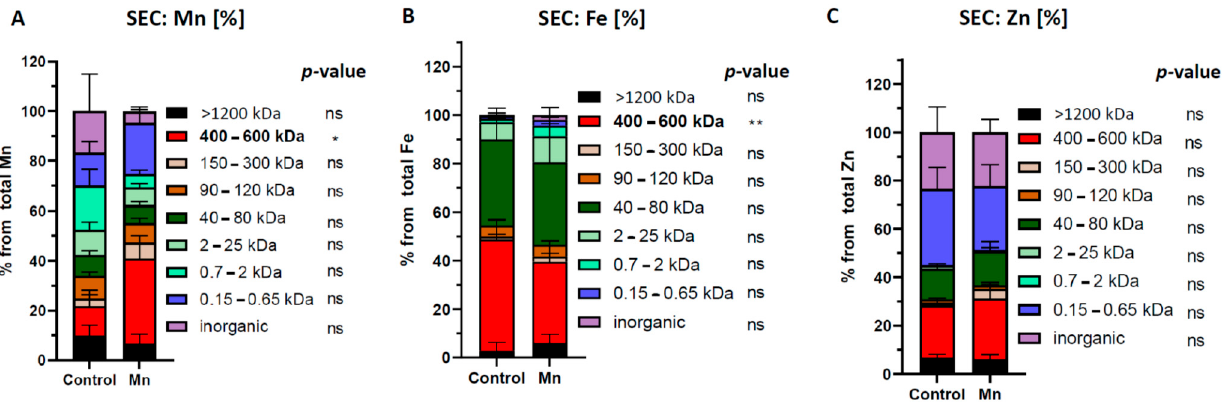
Int. J. Mol. Sci. 2021 , 22 , x FOR PEER REVIEW Figure 3. Pearson’s correlation analyses are shown for element vs. element interactions in serum and CSF samples. No correlation found for any shown element pairs, neither in serum nor CSF. r marks the Pearson correlation coefficient.